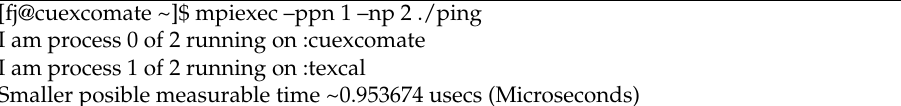
Table 12. Round Trip Time (RTT) evaluation in the Morelos